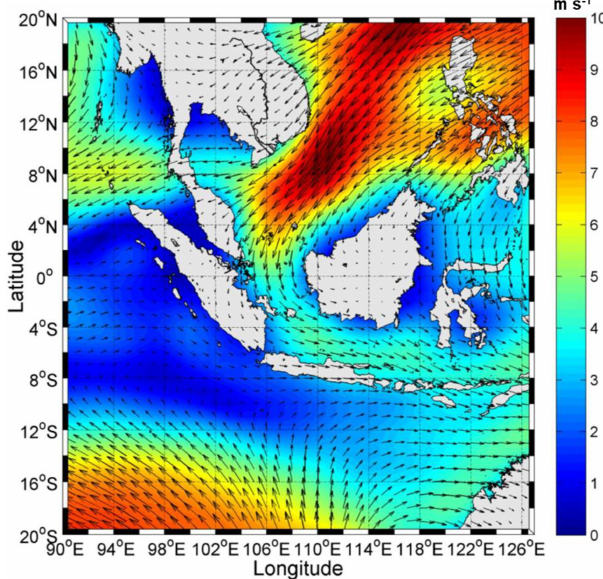
Figure 7. Mean NW monsoon for the period of 1950 to 2013 (cli- matological wind field during the